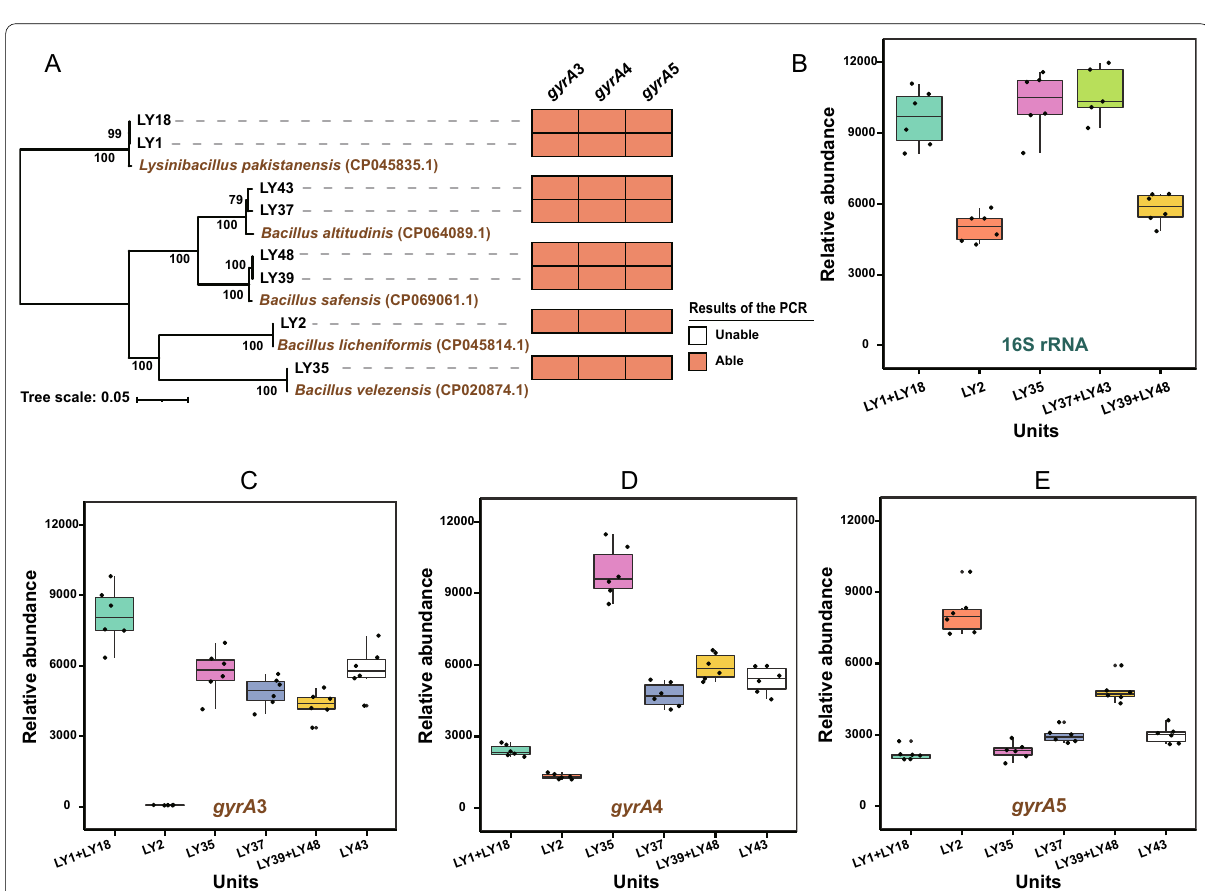
Fig. 5 The results of amplicon sequencing for the mock community including eight Bacillus strains. A PCR amplification of eight Bacillus strains by gyrA gene primer pairs. The orange square indicates positive and white square unsuccessful amplification. The amplicon sequencing results of 16S rRNA gene B and gyrA gene using primer pairs gyrA 3 C , gyrA 4 D , and gyrA 5 E for the mock community. The relative abundance is represented by reads numbers for each unit as indicated on the X axis. The phylogenetic tree was contracted based on the complete gyrA genes (2469 bp) (Additional file 2: Dataset S2) by using the Neighbor‑Joining method in MEGA 5.05 software. The reliability of clades was tested by the 1000 bootstrap replications. The box plots were drawn by the ggplot2 R package